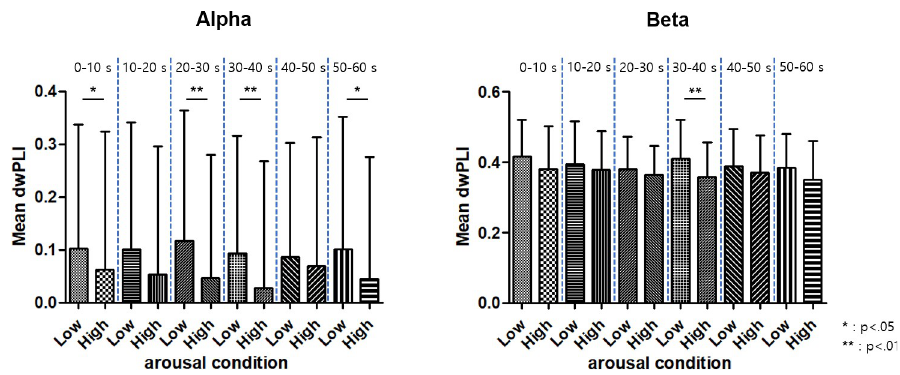
Fig 5. The average debiased weighted phase lag index of the whole network in each 10 s time interval for high and low arousal conditions (alpha- and beta-bands). Asterisks denote significant differences between arousal conditions ( � : p < 0.05; �� : p <